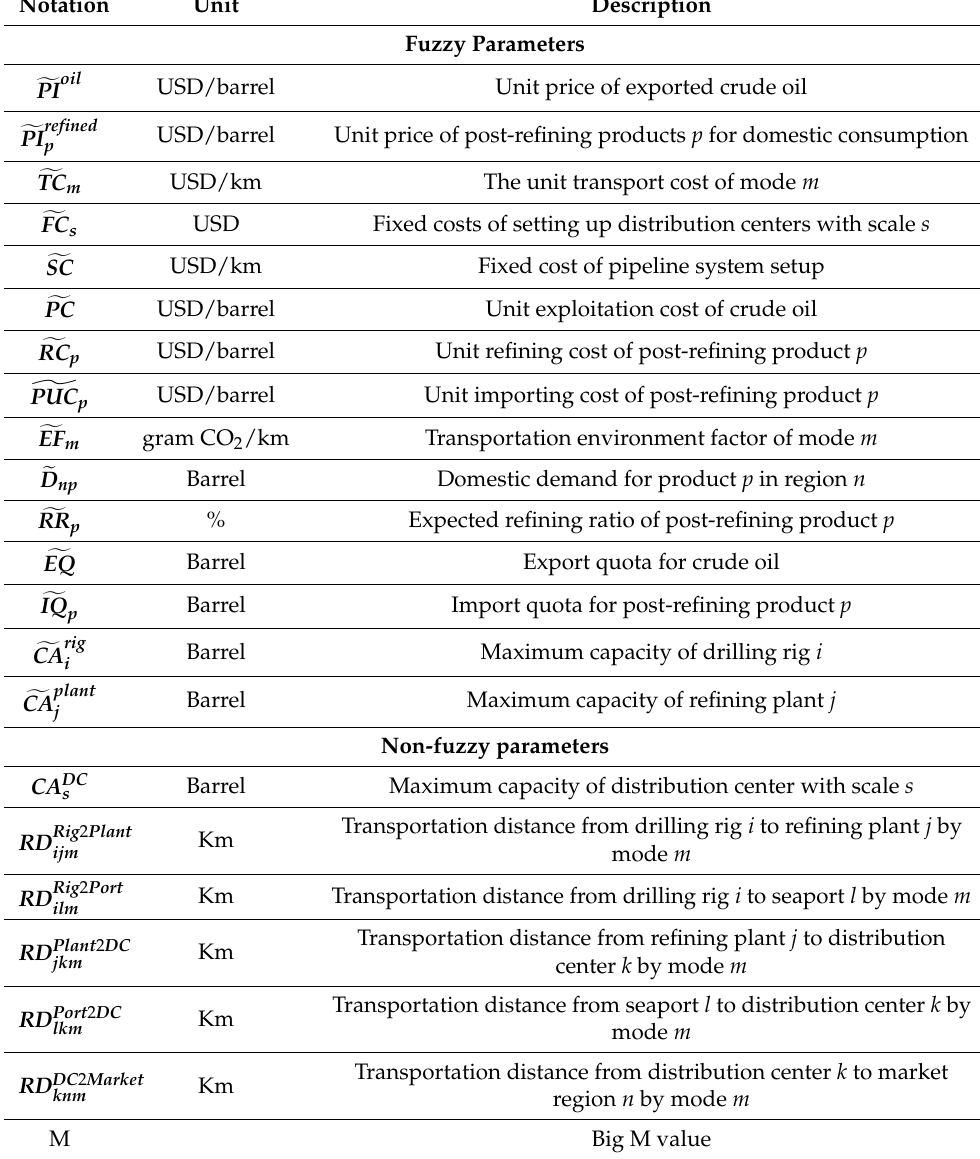
Table 3. Fuzzy and non-fuzzy